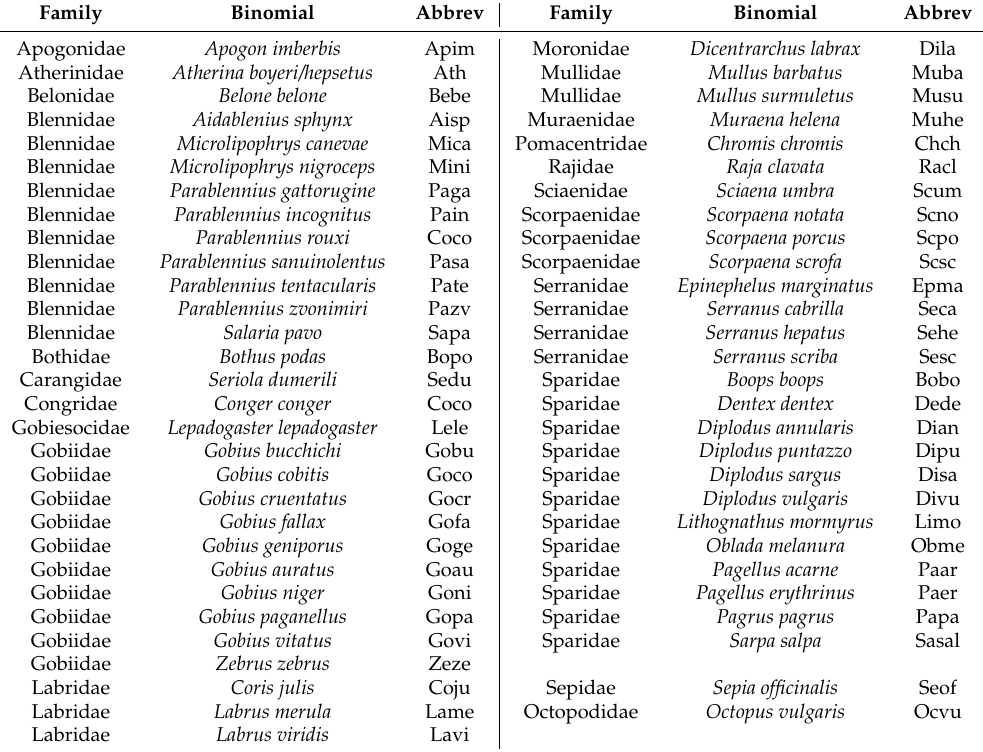
Figure 2. The total number of transects with the indicated benthic habitats present. U: unconsolidated sediment. R: rock. A: macroalgae (usually Cystoseira spp.). P: seagrass Posidonia oceanica . C: seagrass Cymodocea nodosa . Shown are the 30 most common habitat combinations out of a total of 50. Horizontal axis uses a log scale to show relative sizes of the bars more clearly. Table 2. Family, genus, and species corresponding to abbreviations used in Table 1 and Figure 4.